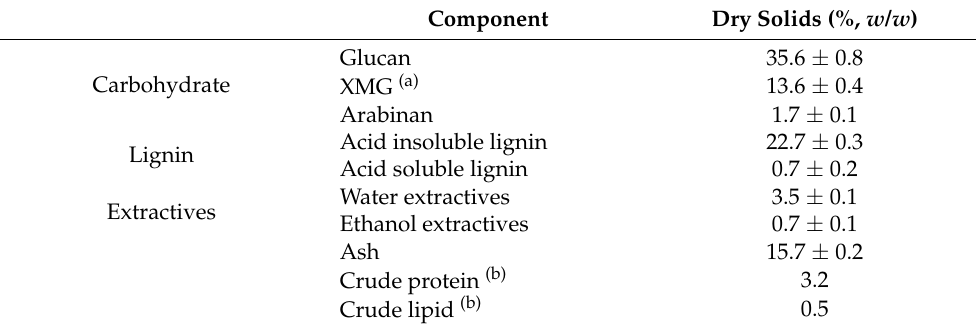
Table 1. Chemical composition of rice